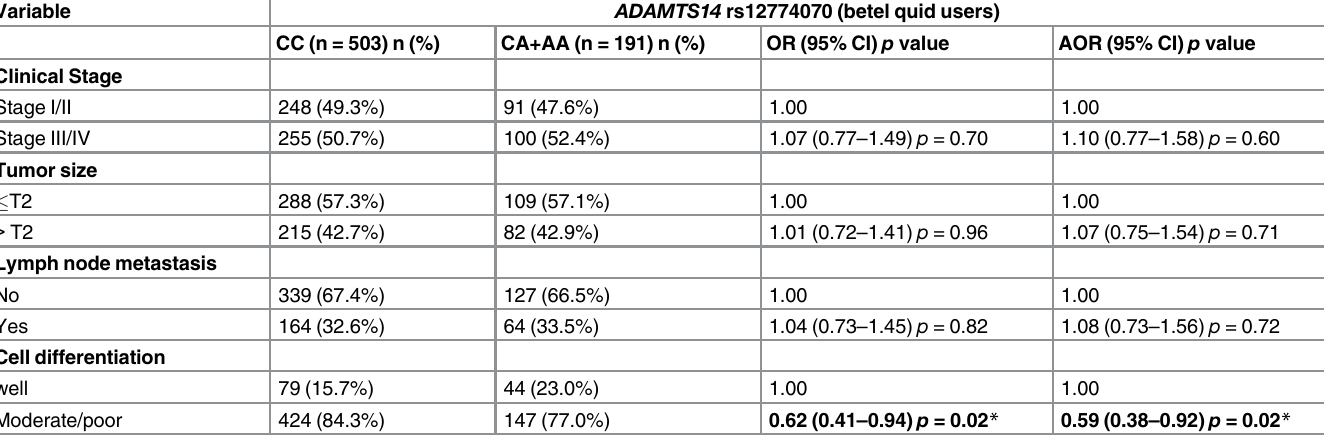
Table 5. Associations of genotype frequencies of ADAMTS14 rs12774070 with clinical status of oral cancer among 694 betel quid users.